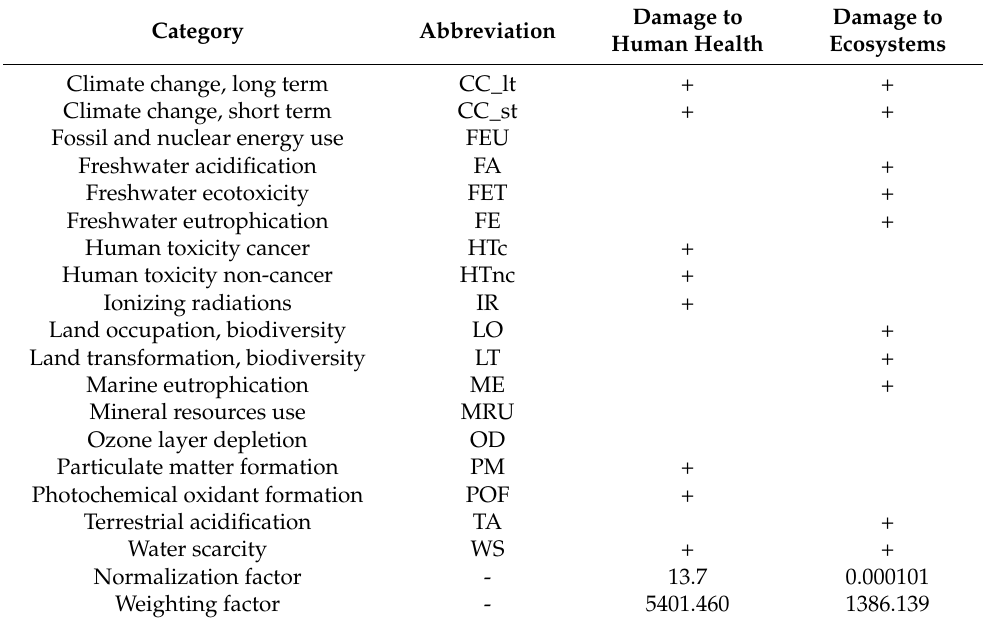
Table 3. IMPACT World+ midpoint-damage impact categories and normalization/weighting